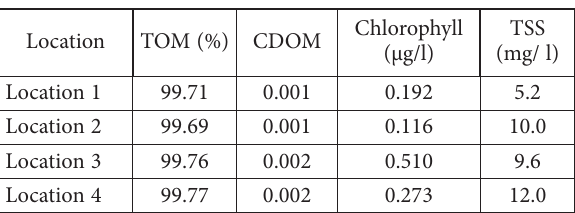
Table 4. Constituent content at four locations (source: